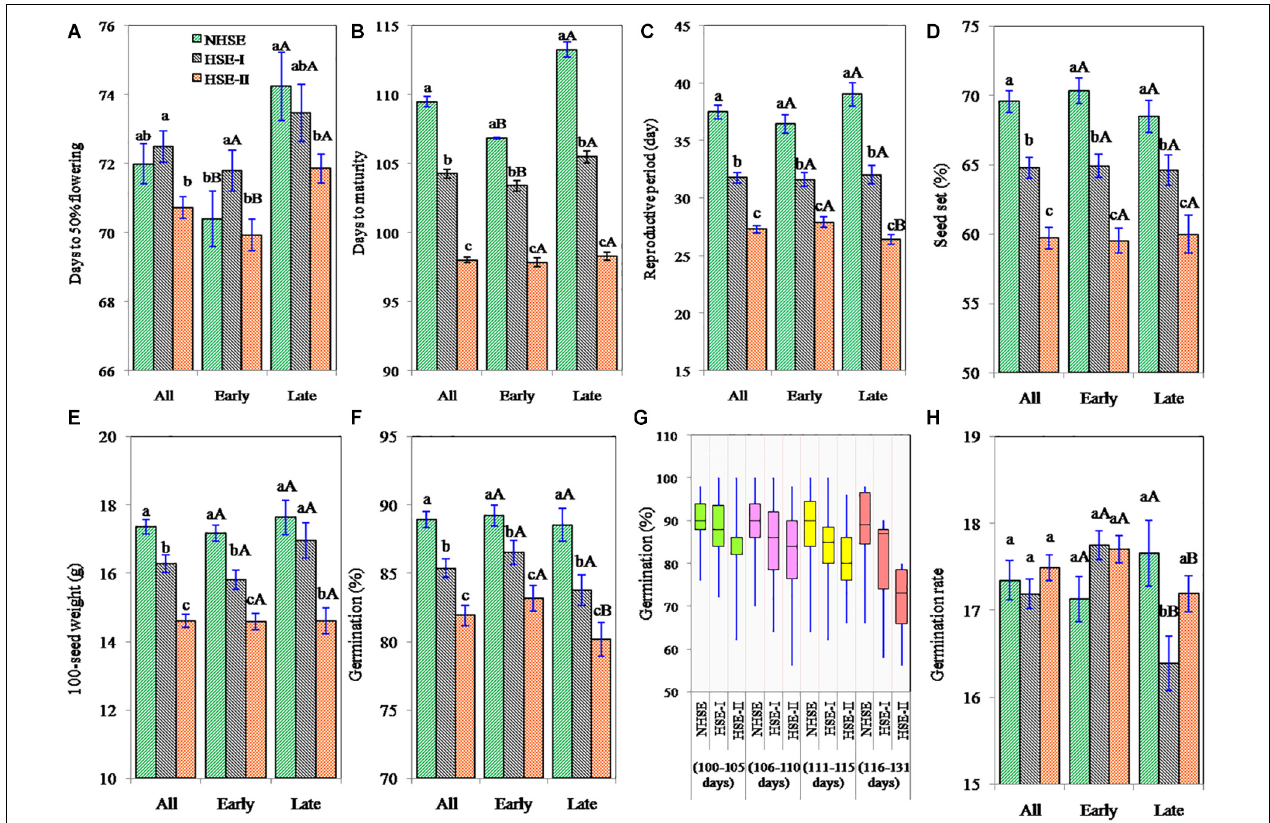
FIGURE 3 | Days to 50% flowering (A) , days to maturity (B) , reproductive period (C) , percent seed set (D) , 100-seed weight (E) , seed germination (F,G) , and germination rate (H) of early, late, and overall field pea genotypes under timely sown and late-sown conditions. The error bars represent mean ± standard error of means. Different lowercase letters (a–c) represent significant difference ( p < 0.05) within the row values (between environments). Different uppercase letters (A,B) represent significant difference ( p < 0.05) within the column values (between early and late genotypes).